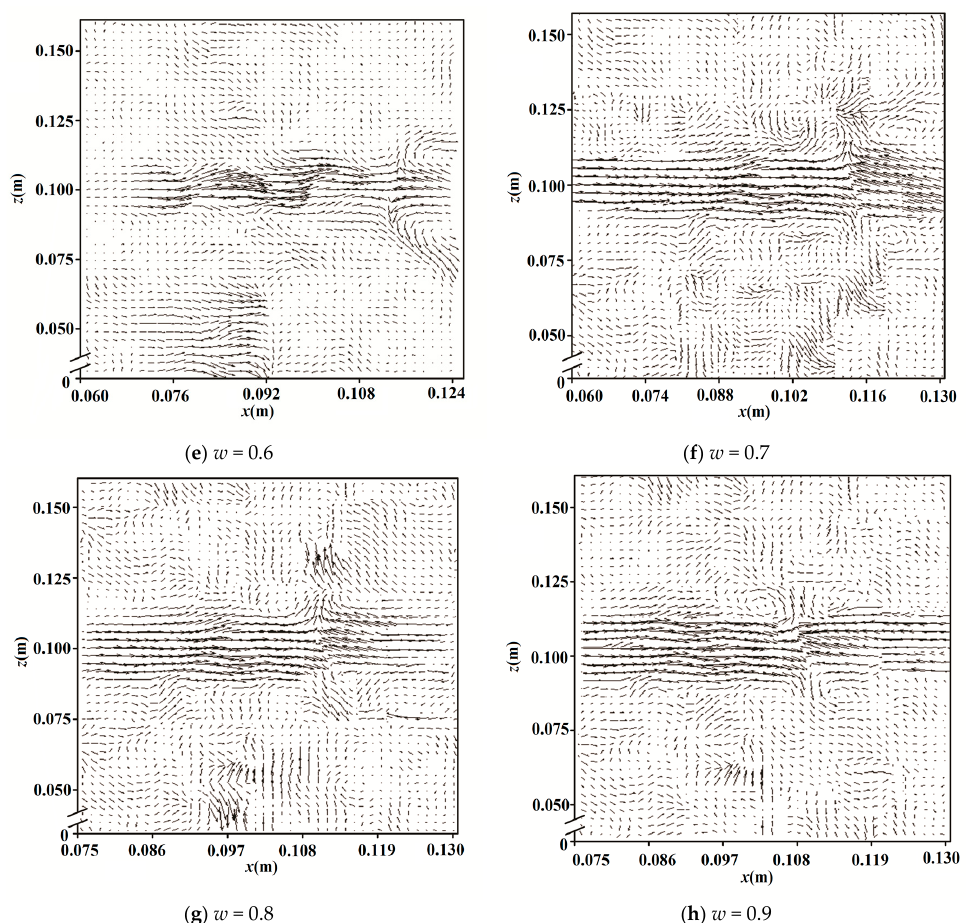
Figure 8. Instantaneous velocity vector maps of the xz plane, as determined using particle image velocimetry (PIV) for the sinusoidal inlet velocity at u m = 1.25 m/s, T = 0.4, A = 0.25 m/s, L/D = 4 and ∆ (cid:2030) = T /2 in one period.